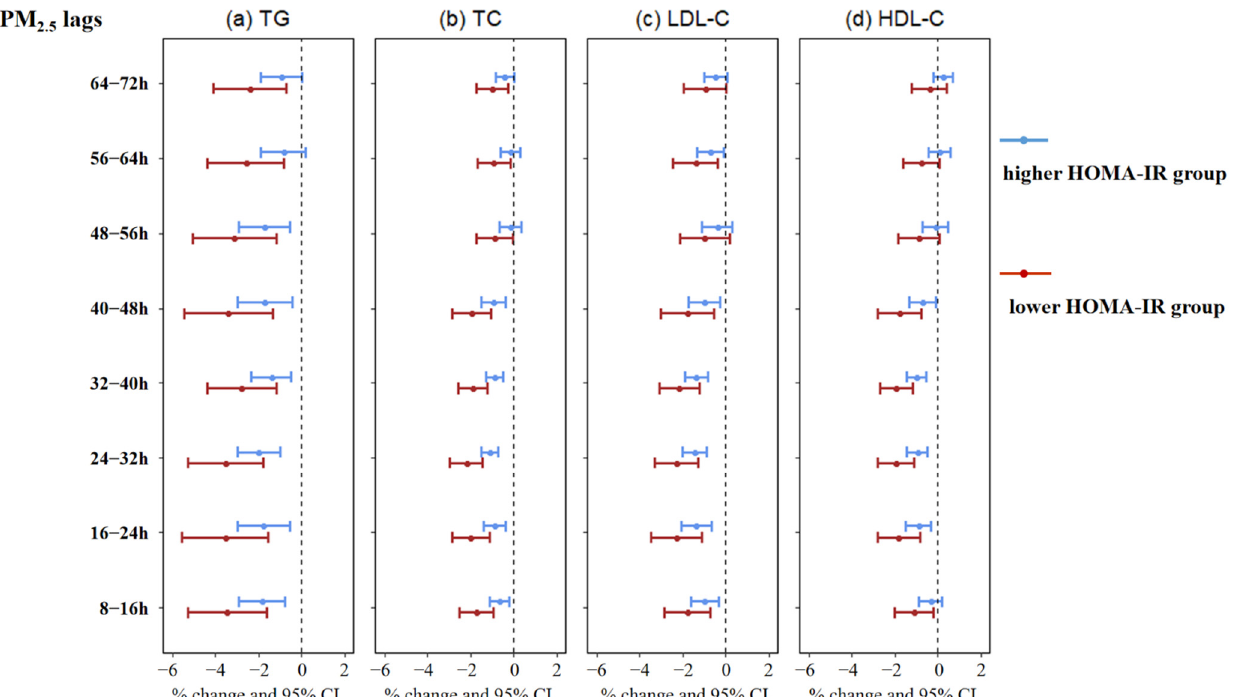
Figure 2. The interaction effects of PM 2.5 exposure and HOMA-IR on TG ( a ), TC ( b ), LDL-C ( c ), and HDL-C ( d ). X-axis, lagged time window of PM 2.5 exposure; Y-axis, the estimate effects (percentage change and 95% CI) of PM 2.5 on blood lipids after stratification by the median of HOMA-IR. Adjusted for temperature, humidity, age, gender, BMI, the day of the week, exercise status, alcohol, and caffeine. Abbreviations: HOMA-IR, homeostasis model assessment of insulin resistance.